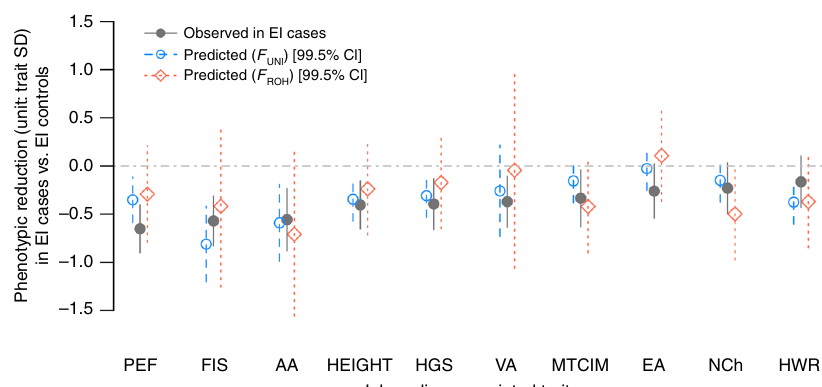
Fig. 4 Phenotypic reduction (in trait standard deviation; SD) observed in 125 extreme inbreeding (EI: F ROH > 0.1) cases compared to 345,276 unrelated EI controls ( F ROH < 0.01). Observed means for EI cases and controls are reported in Table 3. Phenotypic reduction was assessed for ten traits: auditory